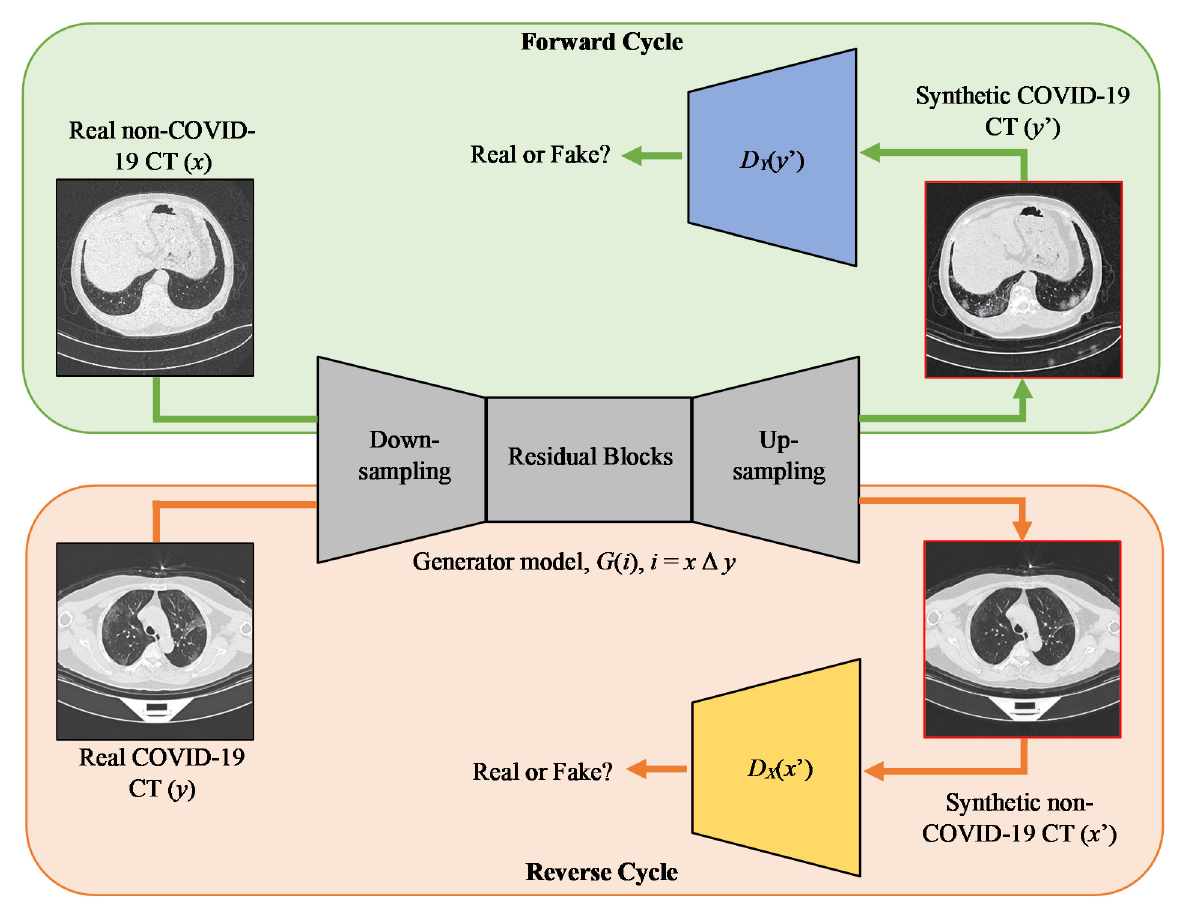
Figure 3. Overview of the sRD‑GAN framework. Bidirectional image mapping uses only a single generator model and two different discriminative models for both mapping directions.